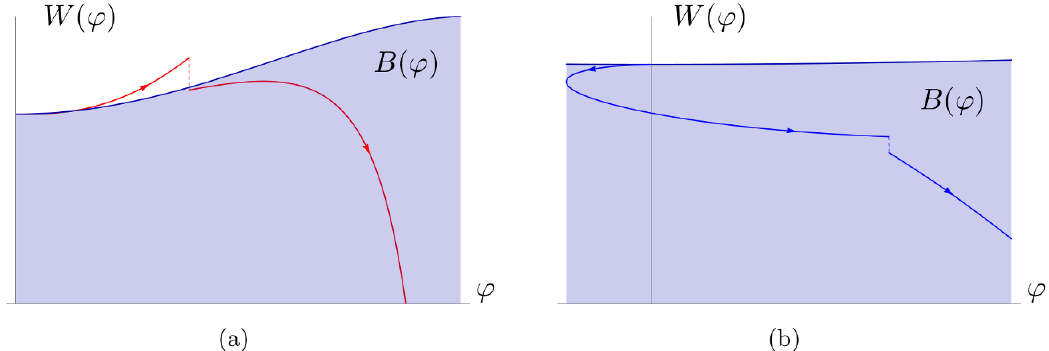
Figure 11 . Two solutions for W ( ’ ) with the same (negative) value of R but di(cid:11)erent sign of ’ (cid:0) . The results were obtained for bulk potential (3.1), brane quantities (3.2) and parameter values (3.3). The jump in W is the discontinuity across the brane. In (cid:12)gure (a) we plot a solution with ’ (cid:0) > 0, while in (b) a solution with ’ (cid:0) < 0 is shown. Note that the solution with ’ (cid:0) < 0 exhibits a bounce, i.e. a reversal of direction in ’